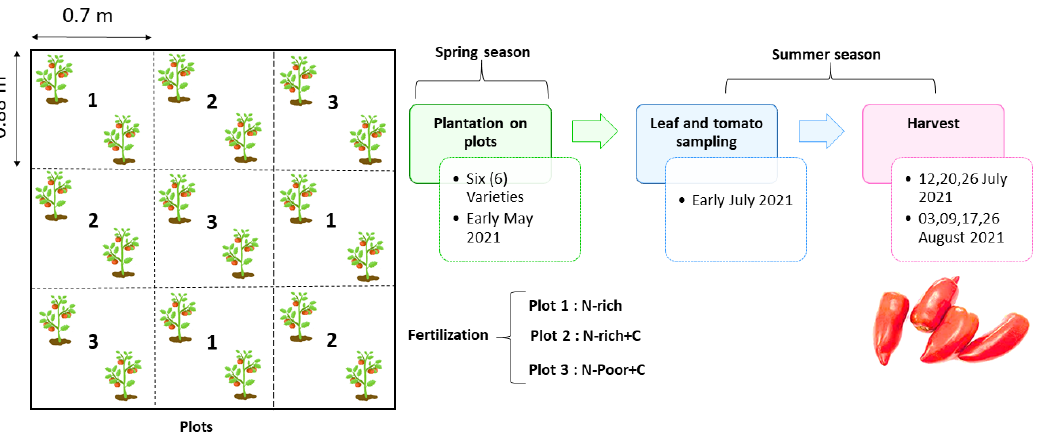
Figure 1. Field experimental layout of the application of different doses of N and C in the cultivation of six tomato varieties.